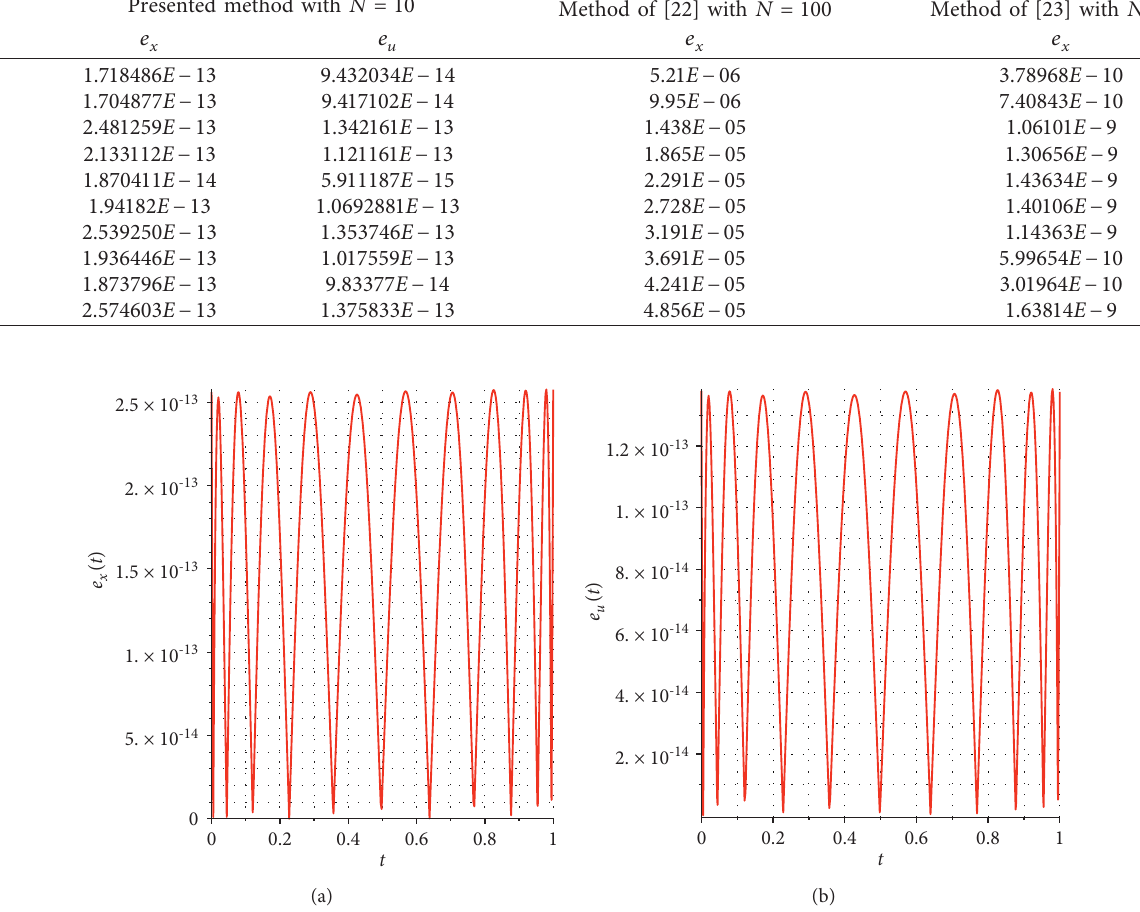
Figure 3: Absolute error of x ( . ) and u ( . ) with N � 10 for α � 1 in Example 2. (a) Absolute error of x ( . ) . (b) Absolute error of u ( . ) .